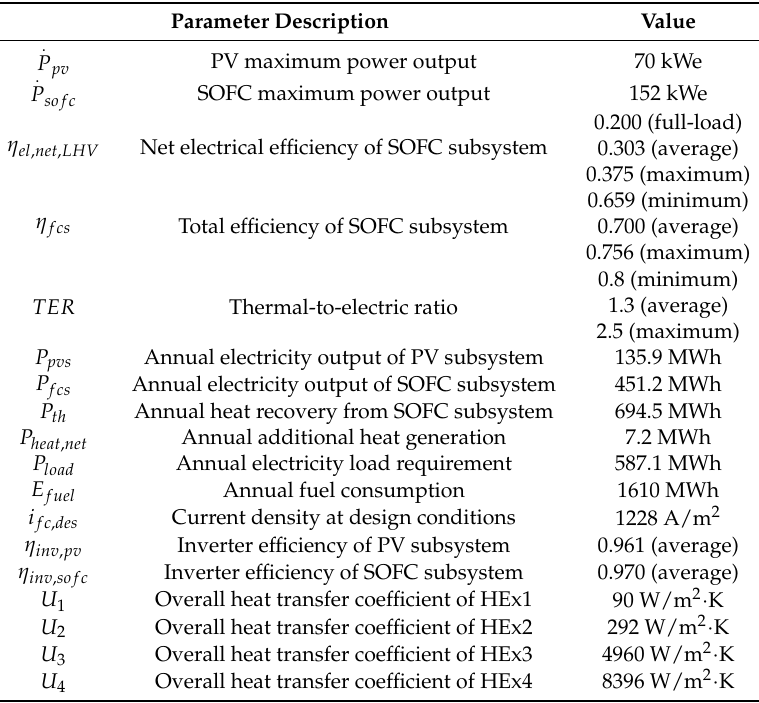
Table 4. Performance characteristics of the proposed hybrid PV-SOFC system.